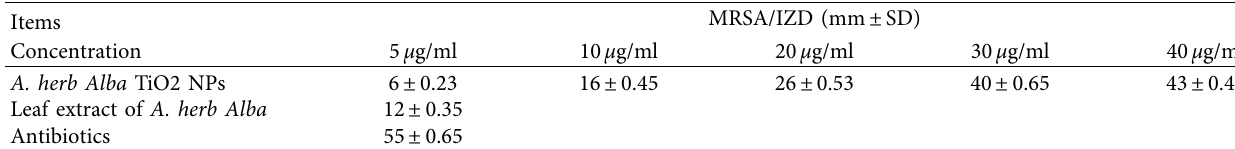
Figure 4: (a) An antibiotic sensitivity test for isolated S. aureus shows resistance (R) and sensitivity (S) of MRSA to diferent antibiotics. (b, c) Inhibition zone diameter (IZD) against isolated MRSA using leaf extract of A. herb Alba and A. herb Alba TiO2 NPs. Table 6: Inhibition zone diameter of A. herb Alba TiO2 NPs against